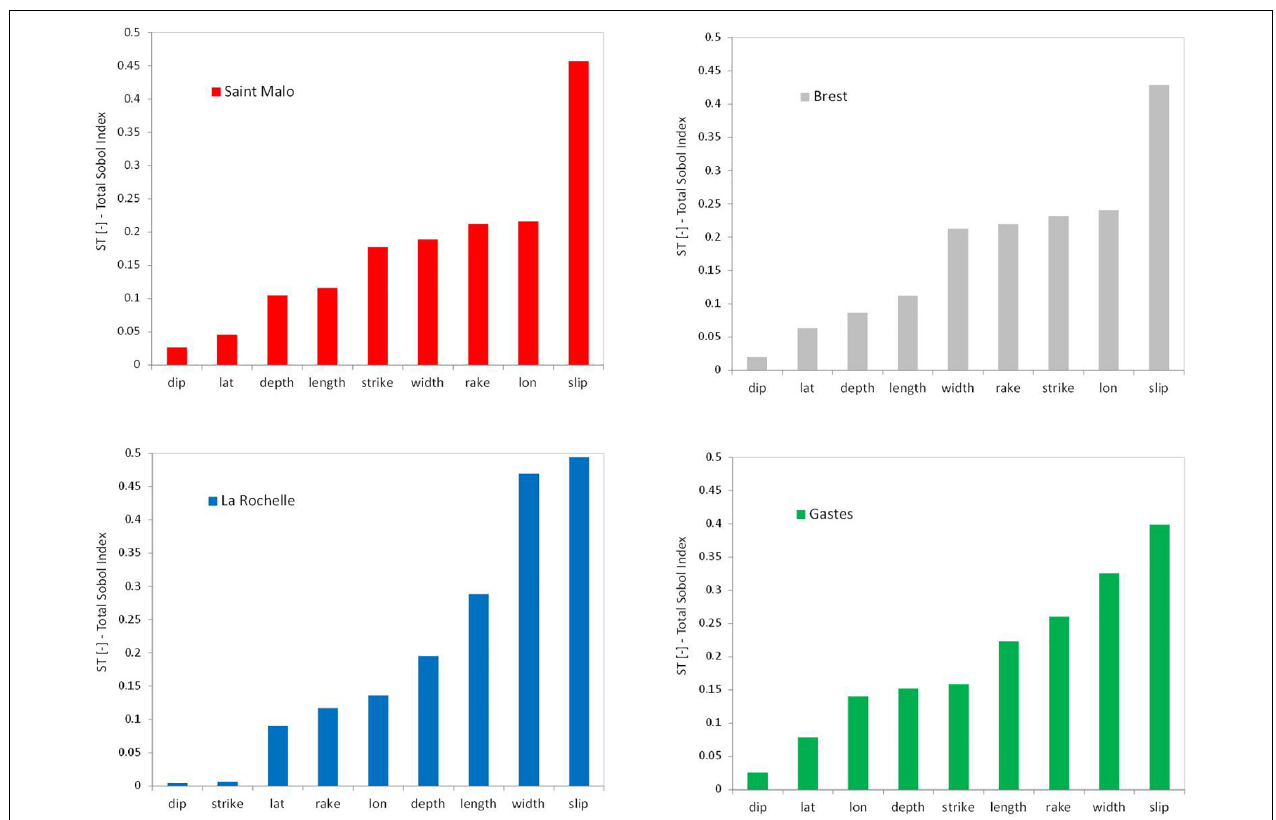
FIGURE 7 | Total order Sobol Index computed for the French Atlantic